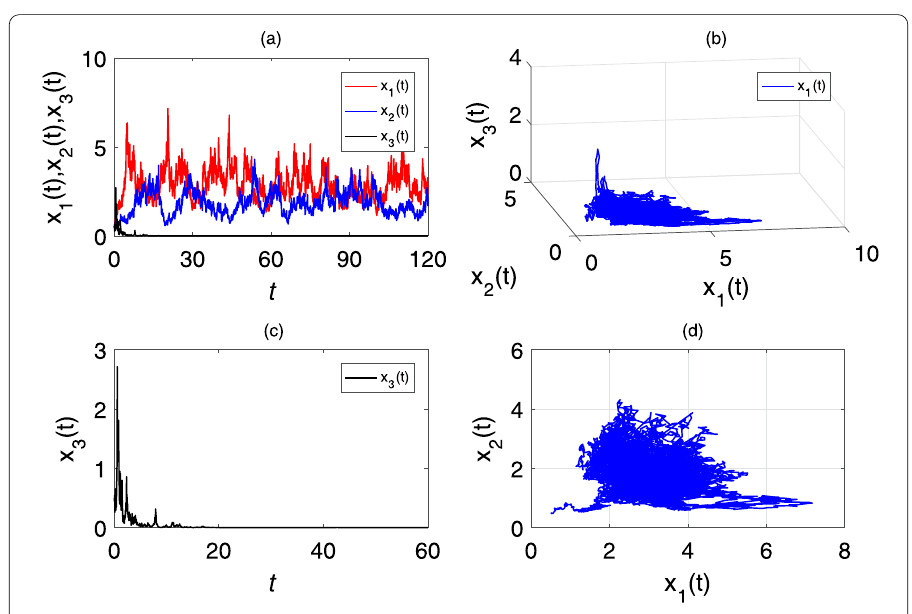
Figure 6 Non-persistent in the mean of the predator population x 3 ( t ) of system (2). (a) Time sequence diagram and (b) the phase portrait of system (2).( x 1 (0), x 2 (0), x 3 (0)) = (0.5,0.5,0.5), σ 2 1 ( t ) = σ 2 2 ( t ) = 0.1+0.04sin t , σ 2 3 ( t ) = 2.1624 + 0.04sin